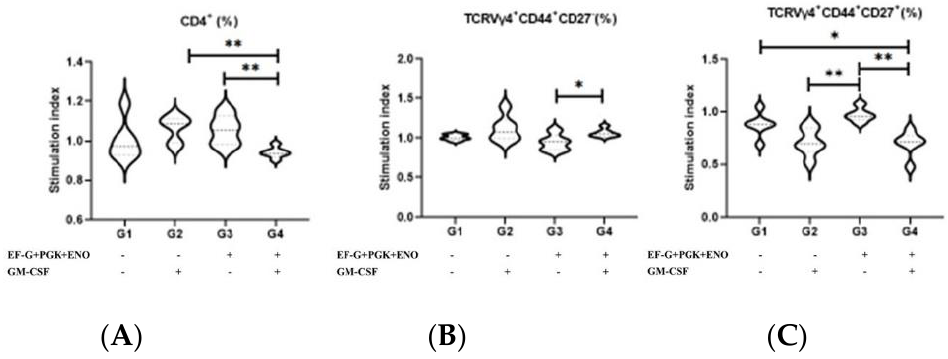
Figure 4. Percentage of T CD4 + cells in immunized animals, and the antidromic trend of the percentage TCRV γ 4 + effector and central memory cells in mice vaccinated with GM-CSF DNA vaccine. ( A ) Overall T CD4 + , ( B ) TCRV γ 4 + CD44 + CD27 − (effector memory cells), and ( C ) TCRV γ 4 + CD44 + CD27 + (central memory cells). GM-CSF: Granulocyte-macrophage colony-stimulating factor; EF-G: elongation factor-G, ENO: enolase; and PGK: phosphoglycerate kinase. * Indicate p ≤ 0.05, ** indicate p ≤ 0.01. (One-way ANOVA followed by Tukey test).